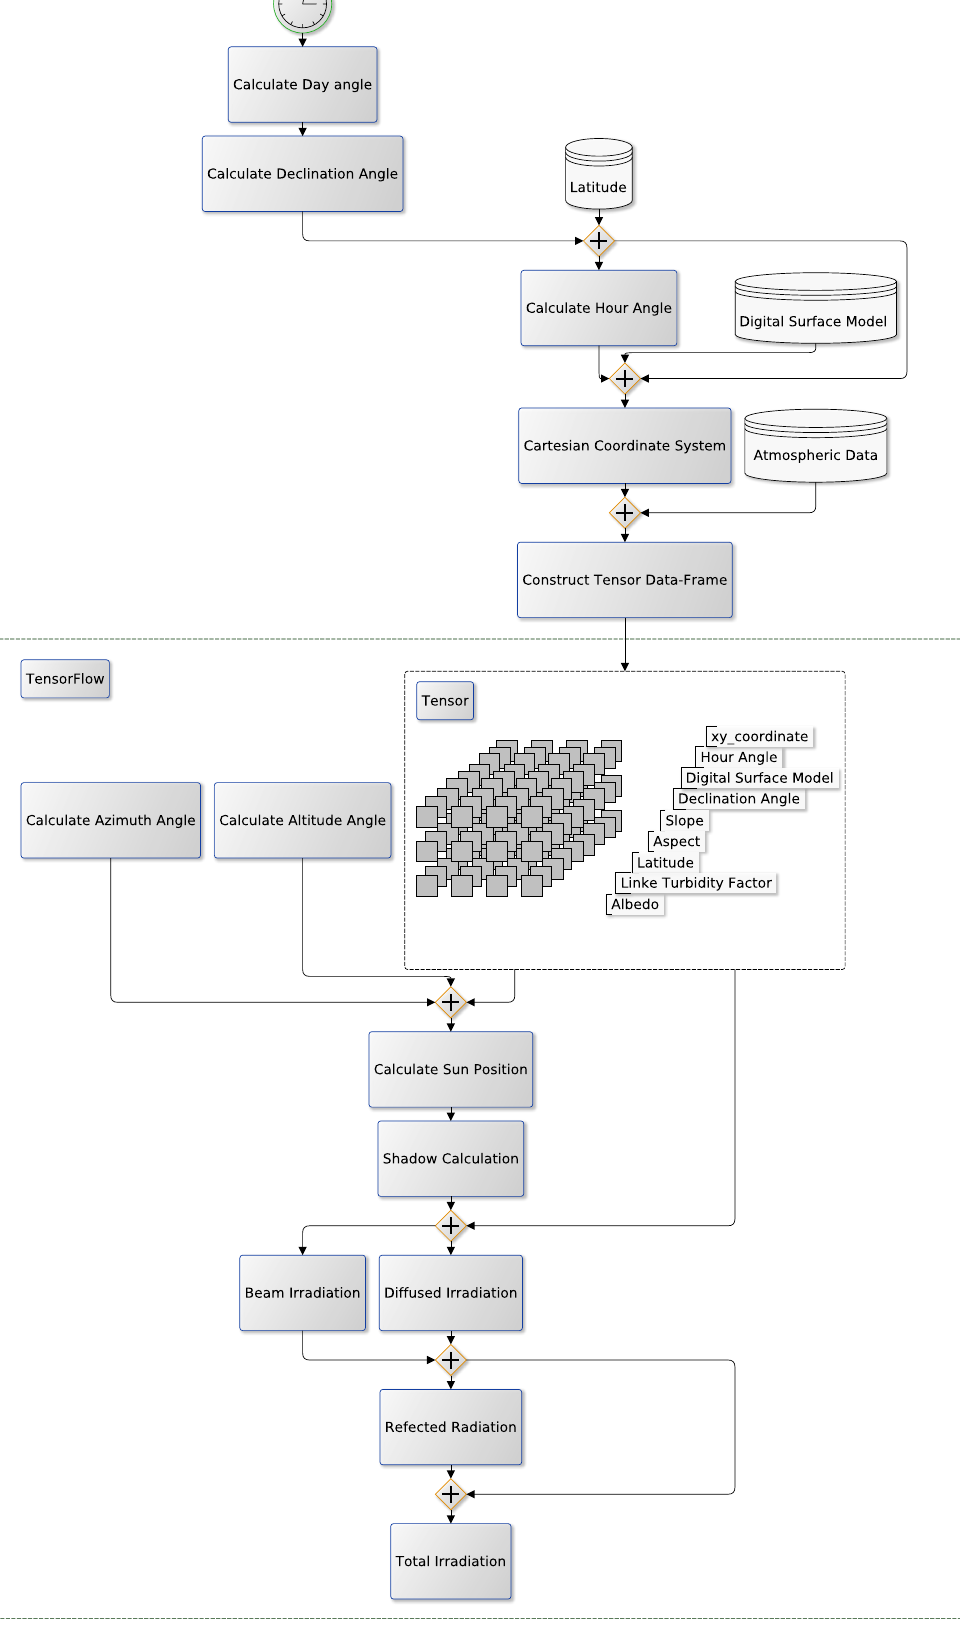
Figure 11. Tensor Based Solar Irradiation Modeling